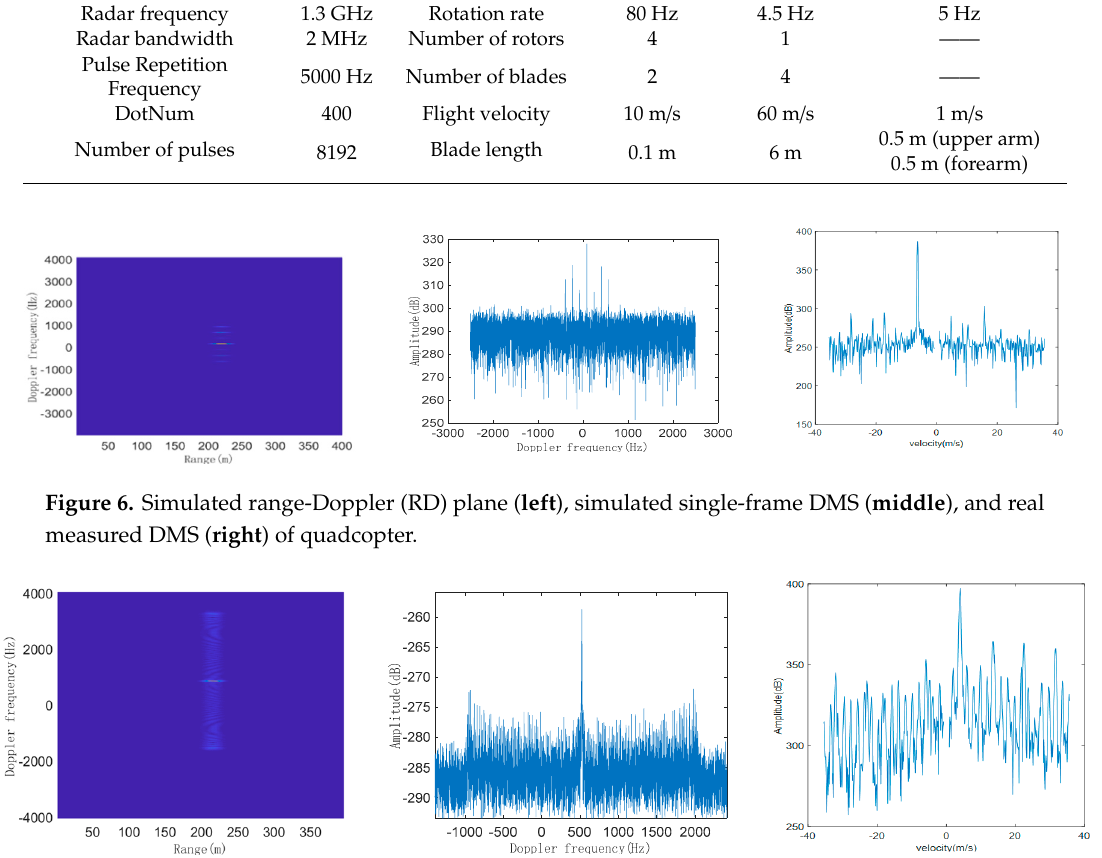
Figure 7. Simulated RD plane ( left ), simulated single-frame DMS ( middle ), and real measured DMS ( right ) of helicopter.